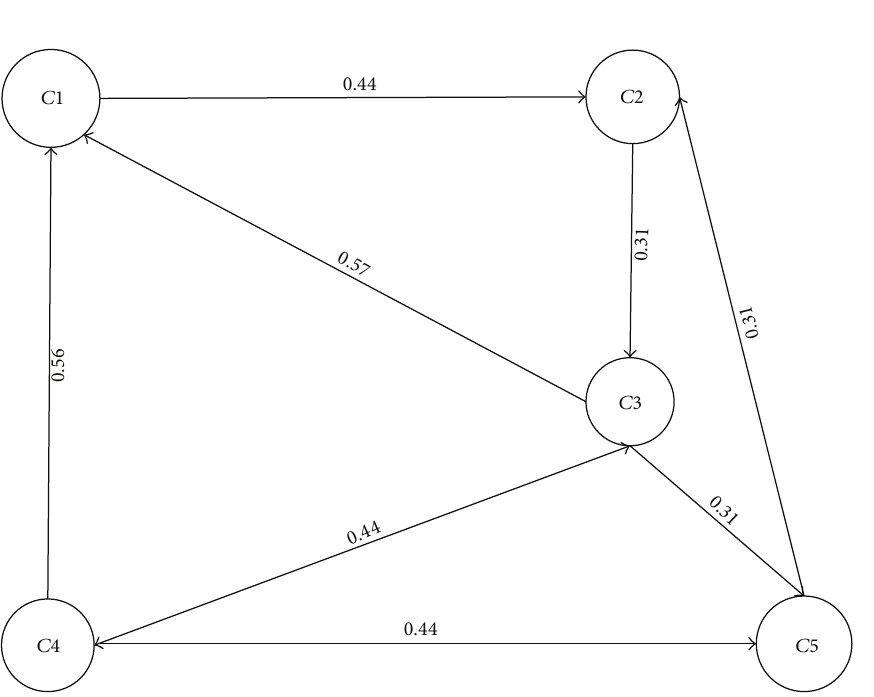
Figure 6: Intuitionistic fuzzy digraph of a road network.